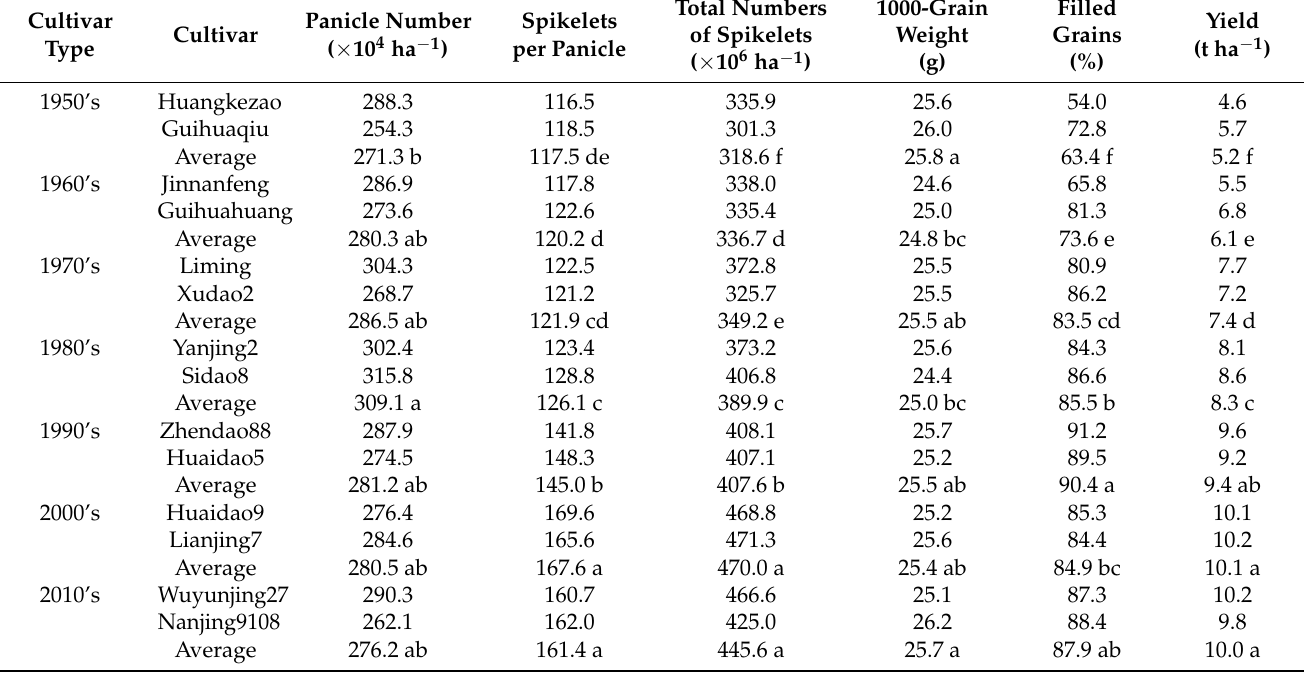
Table 2. Changes in grain yield and its components during japonica rice cultivar